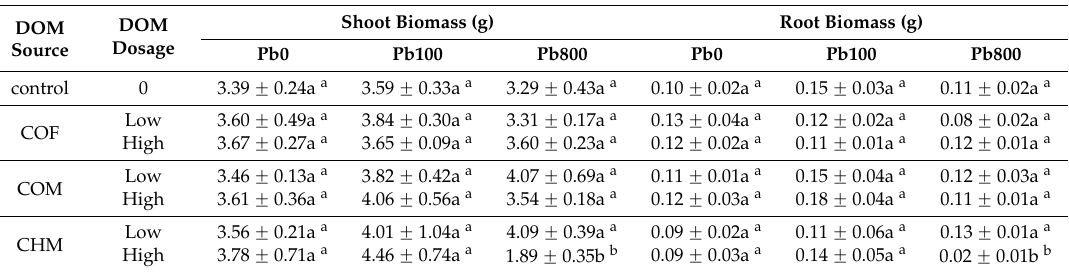
DOM: stands for dissolved organic matter; COF: represents commercial organic fertilizer; COM: cow manure: CHM: chicken manure; Pb0, Pb100 and Pb800 denote the pot soils to which 0, 100 and 800 mg ¨ kg ´ 1 Pb were added, respectively. The different superscript letters in the same row indicate significant difference in shoot or root biomass ( p < 0.05) among the soil Pb levels according to the LSD (Least Significant Difference) test. The different letters following the data in the same column indicate significant difference in shoot or root biomass ( p < 0.05) among DOM treatments according to the LSD test. Data are means ˘ SE ( n = 3).